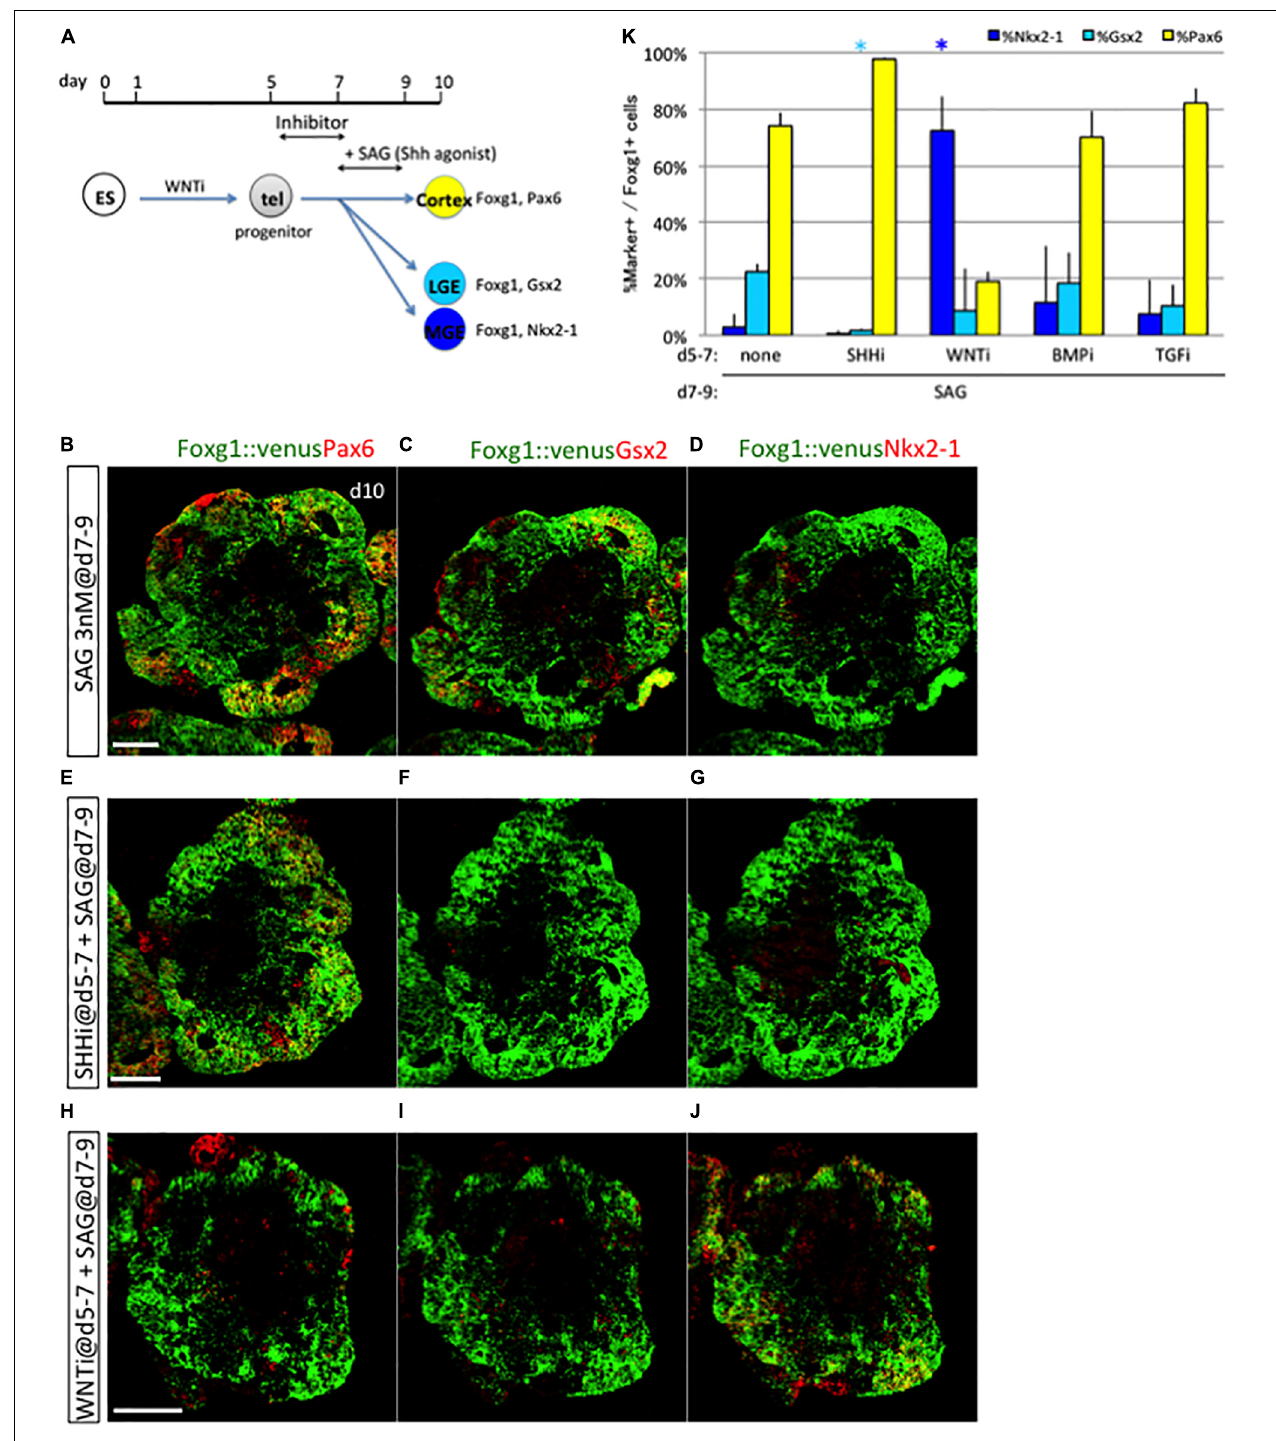
FIGURE 7 | Prerequisite condition for subsequent LGE/CGE induction. (A) Schematic of the 3D culture used to identify the signaling pathway responsible for LGE/CGE induction. Disruption of LGE/CGE induction by Shh signal exposure during days 7–9 due to the absence of any endogenous signal during days 5–7 indicates the need for a prerequisite condition. Inhibitors for Shh signal (cyclopamine), WNT signal (WNTi), BMP signal (LDN193189), and TGFb signal (SB 431542) were added to the culture during days 5–7 with subsequent Shh signal exposure (SAG) during days 7–9. (B–J) Aggregates cultured without any inhibitor (B–D) or with inhibitors for the SHH (E–G) and WNT (H–J) signaling pathway during days 5–7 and then treated with SAG during days 7–9. Scale bars, 200 µ m. (K) Proportion (%) of subregional marker + cells among Foxg1 + cells; Pax6 + (yellow bars), Gsx2 + (cyan bars), and Nkx2 - 1 + (blue bars). Early treatment with Shh and WNT signaling inhibitors reduced Gsx2 + cell induction by later SAG exposure. Results expressed as mean ± SEM ( N = 3). * P < 0.05.